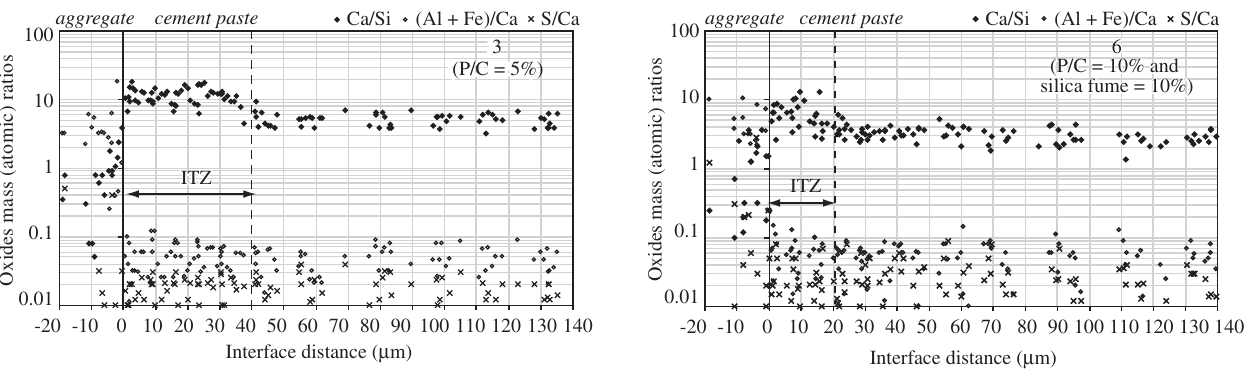
Figure 4. The ratios of Ca/Si, (Al + Fe)/Ca and S/Ca to concrete 3 (P/C = 5%).